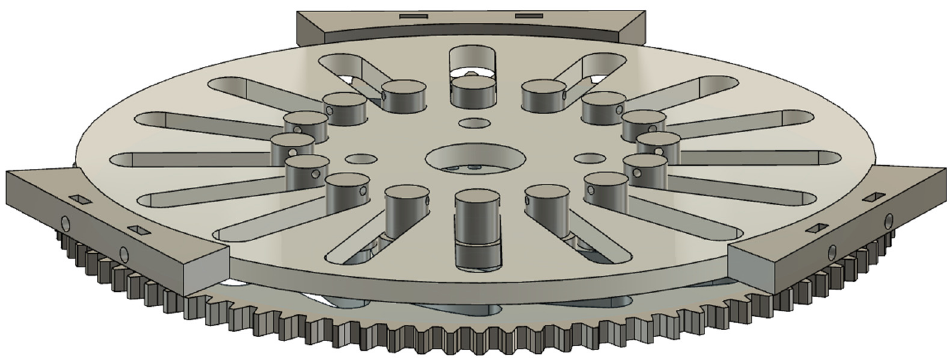
Figure 17. Switching mechanism to change the diameter of the capillary path.